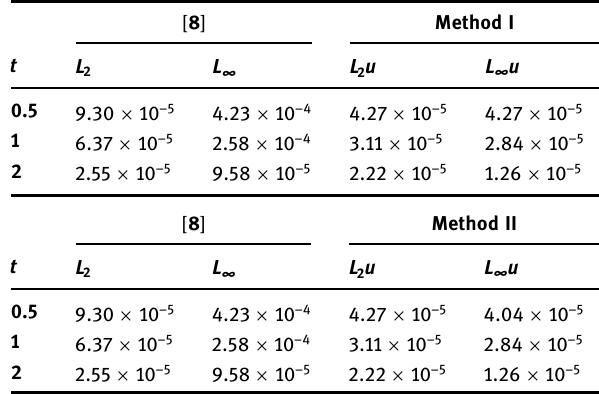
Table 16: Comparison of errors for = α 10 , β = 0, = N 21 , = t Δ 0.0001 , and = τ 0.5 regarding Example 6